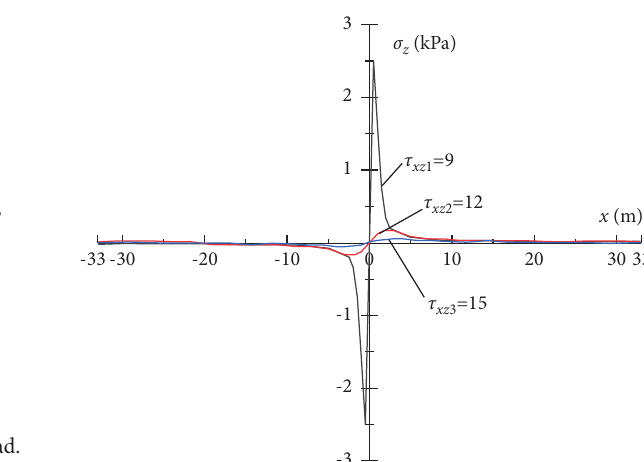
Figure 4: σ z at different burial depths.